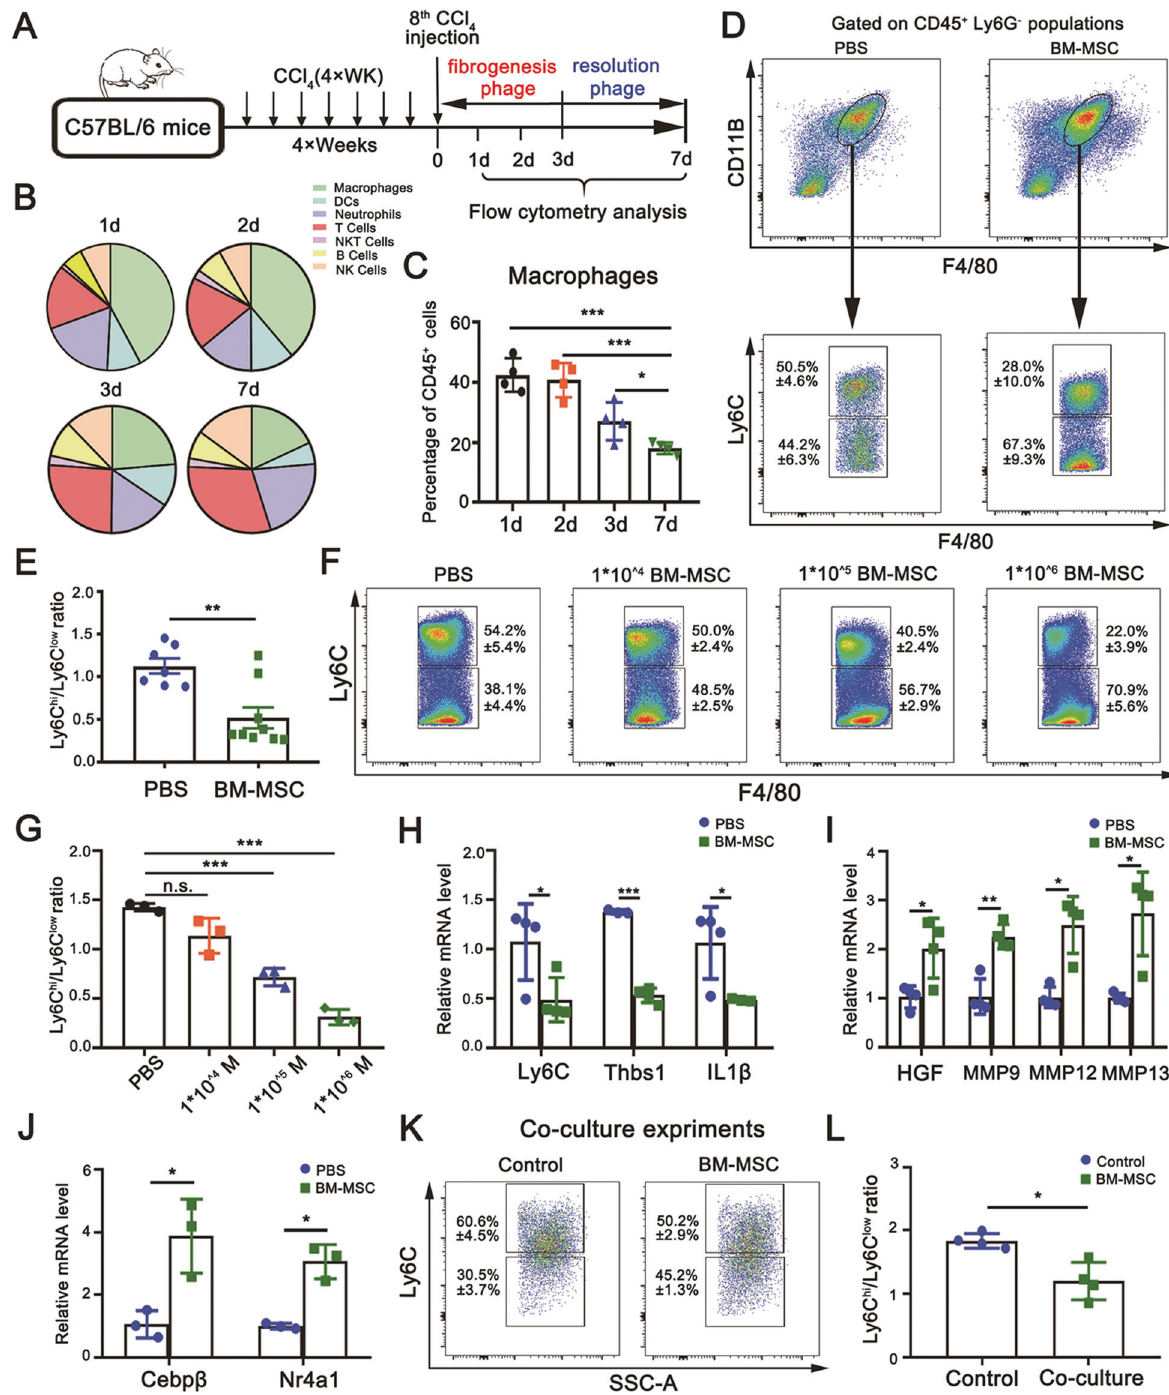
Fig. 2 Evaluation of the contribution of BM-MSCs to the conversion of Ly6C hi to Ly6C lo macrophages. A Schematic of the work model. C57BL/6J mice were i.v. injected with CCl 4 (1mg/kg) twice a week for 4 weeks, followed by FCM analysis to detect different immunocytes at 1, 2, 3 ( fi brogenesis stage), and 7 days (resolution stage) after the fi nal CCl 4 injection. B The proportion of various immunocytes in fi brotic livers at fi brogenesis and resolution after the fi nal CCl 4 injection analyzed by FCM. C FCM analysis showing a strong response of the intrahepatic macrophage population to CCl 4 injury at the early fi brogenesis stage ( n = 4). D , E Alteration in the ratio of Ly6C hi /Ly6C lo macrophages in fi brotic livers 7 days post- BM-MSC transplantation by FCM analysis ( n = 7 and n = 9). F , G FCM analysis showed that the conversion of Ly6C hi to Ly6C lo macrophages in fi brotic livers was conducted in a dose-dependent manner in response to BM-MSC transplantation with different concentrations (0, 1×10 4 , 1×10 5 , and 1× 10 6 ; n = 3). In fi gure ( G ), M is an abbreviation of experimental groups with BM-MSC transplantation. H – J Quantitative real-time PCR analysis for the transcriptional expression levels of pro-in fl ammation markers ( H ), pro-resolution markers ( I ), and transcription factors for Ly6C lo monocyte differentiation ( J ) in CD11B hi F4/80 int macrophages sorted from fi brotic livers at 24h post- fi nal CCl 4 injection ( n = 4 and n = 3). K , L FCM analysis for the phenotypic switch from Ly6C hi to Ly6C lo macrophages by coculturing BM-MSCs with equivalent CD11B hi F4/80 int macrophages isolated from the fi brotic liver for 36h (n = 4). Bars = means±SD. Statistical evaluation of two groups was performed using an independent Student t -test. Statistical evaluation of multiple groups was performed using one-way ANOVA with posthoc LSD test; n.s. p >0.05, * p <0.05, ** p <0.01, *** p